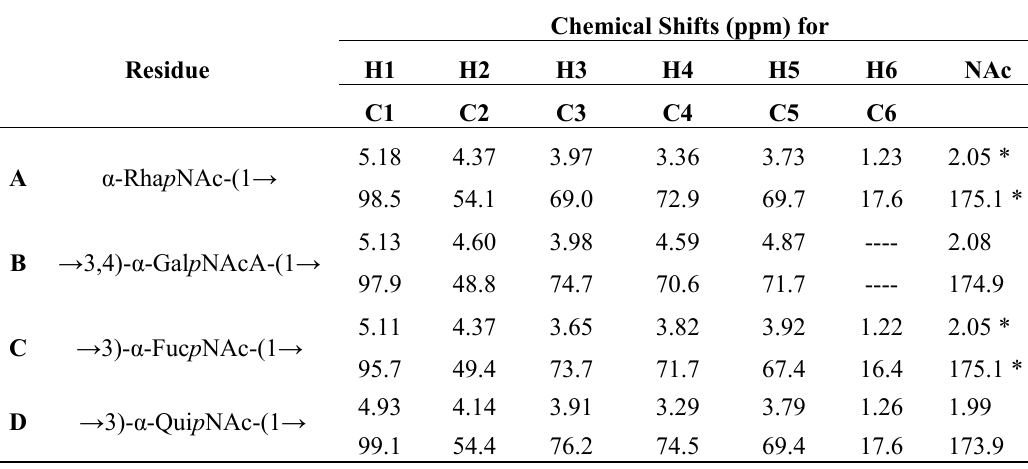
Table 1. 1 H- and 13 C-NMR chemical shifts (ppm) of the PS fraction from P. shigelloides O24. Spectra were obtained for D 2 O solutions at 35 °C.